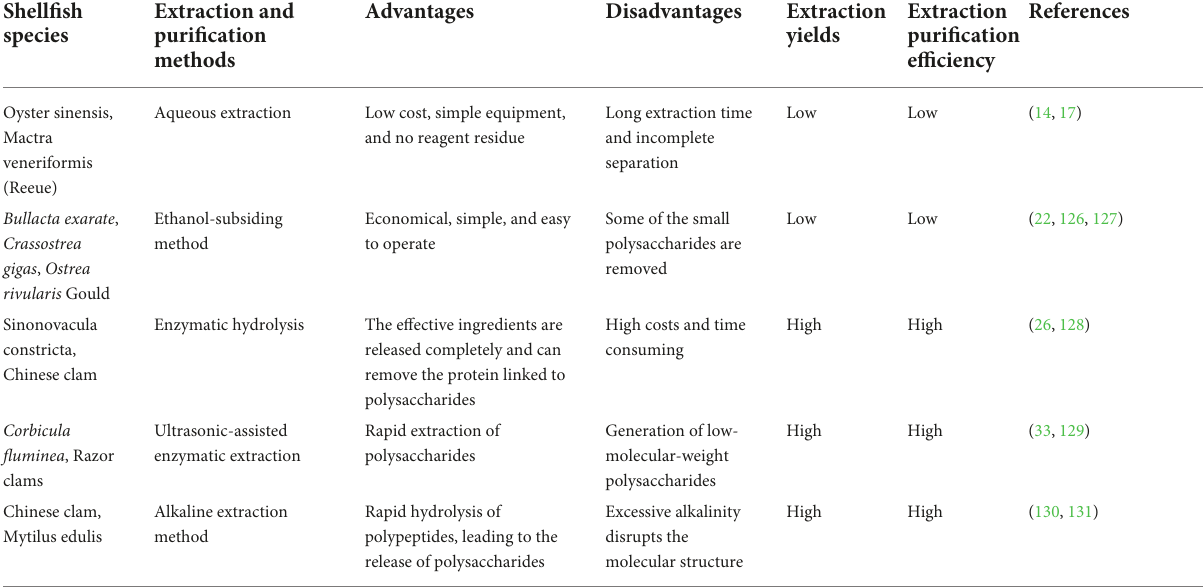
TABLE 2 Comparison of the methods used to extract shellfish polysaccharides. Shellfish